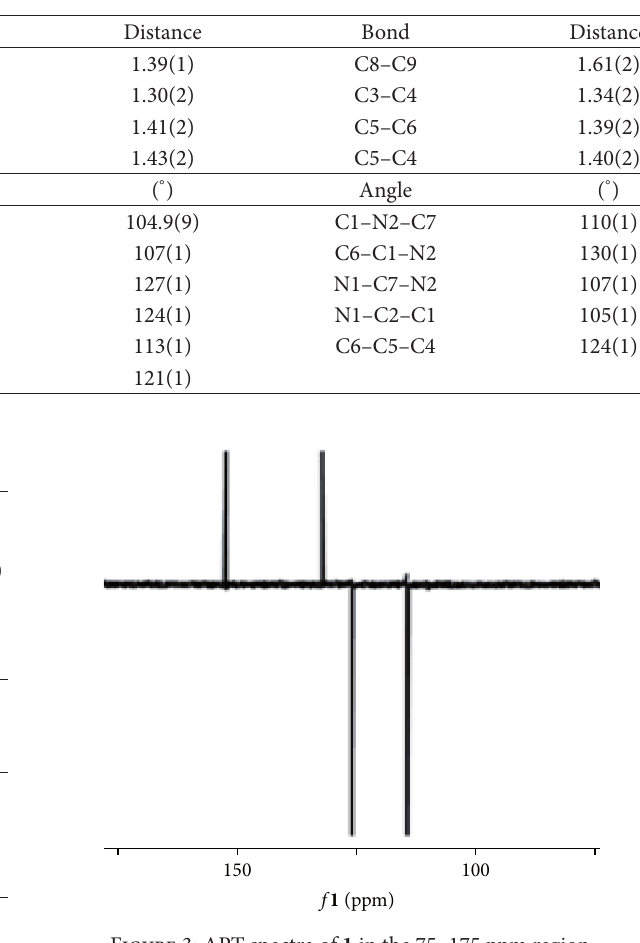
F 3: APT spectra of 1 in the 75–175 ppm region.